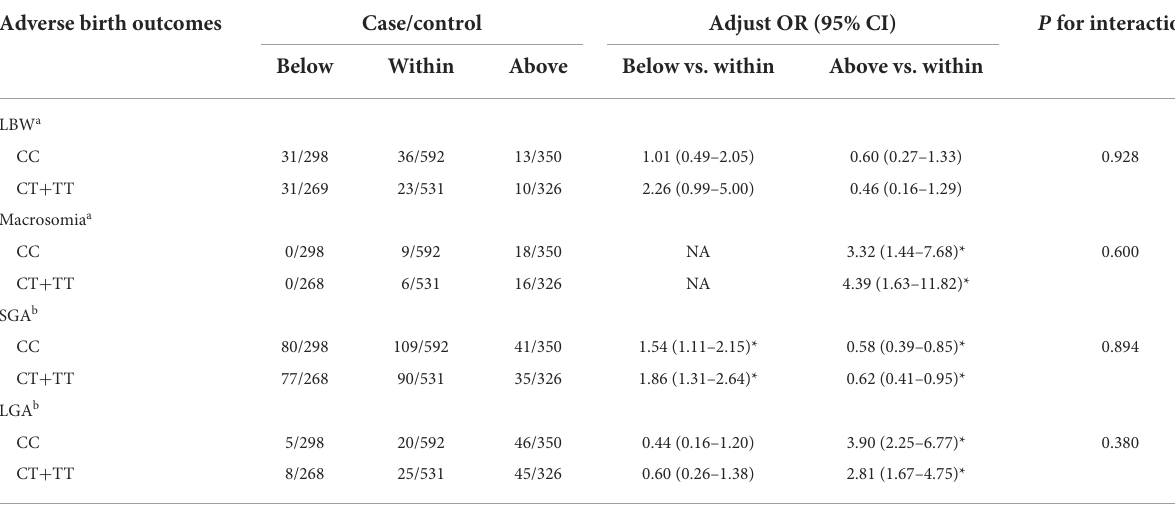
TABLE 4 Associations of GWG categories and adverse birth outcomes stratified by MTHFR C677T polymorphisms. Adverse birth outcomes Case/control Adjust OR (95% CI) P for interaction c Below Within Above Below vs. within Above vs. within